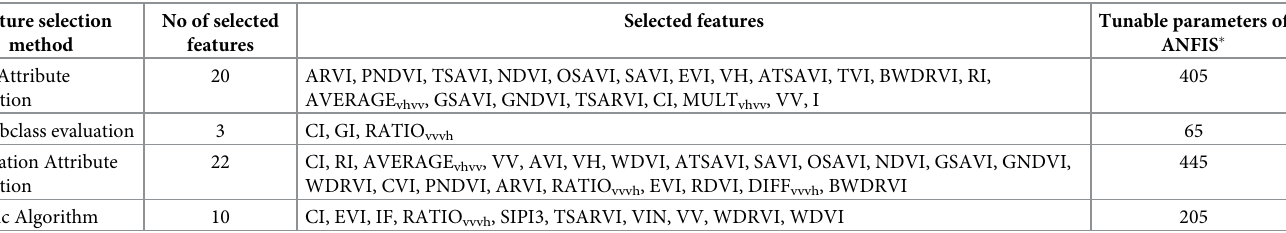
Table 4. Selected features from different